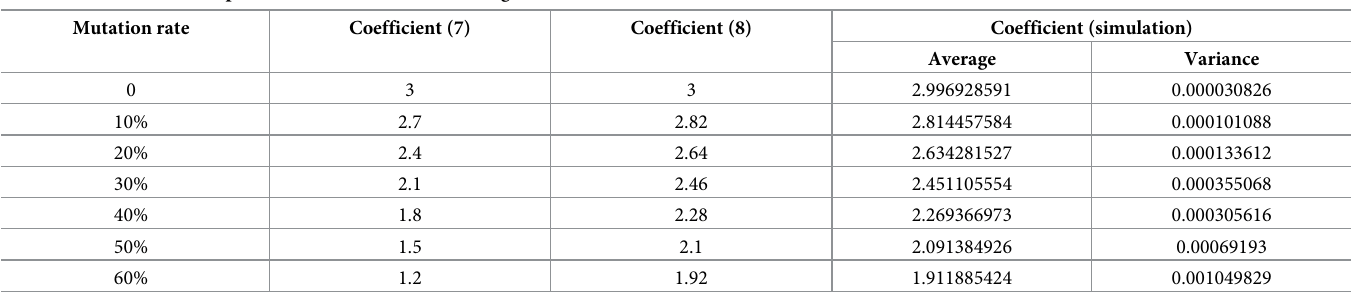
Table 7. Cross-correlation peak to L ratio for the 3 × 3 coding set.